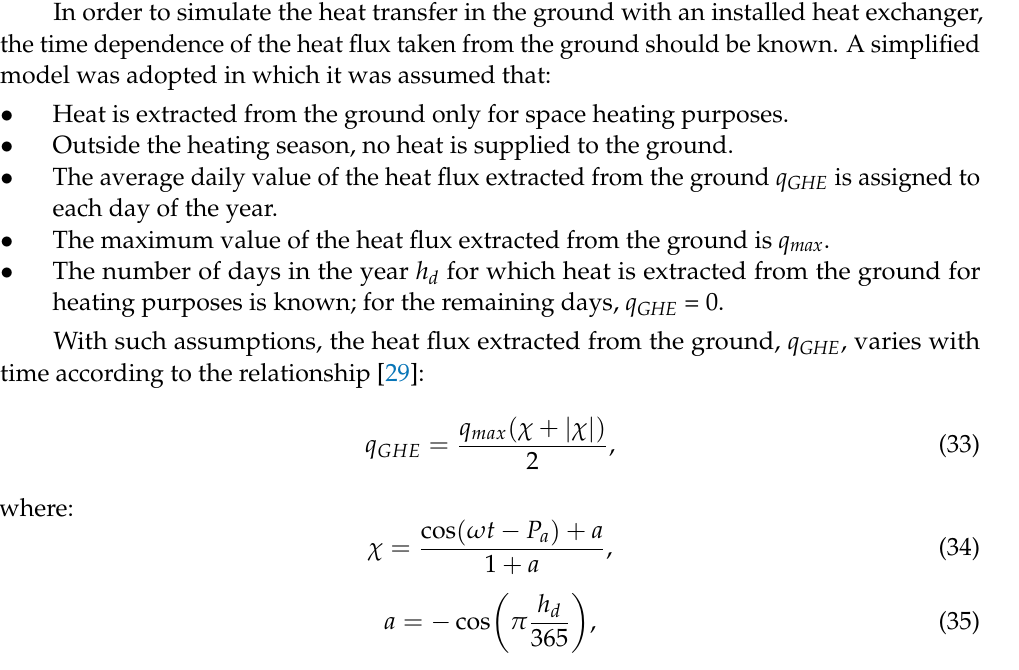
Figure 5. Annual courses of heat flux on the ground surface.